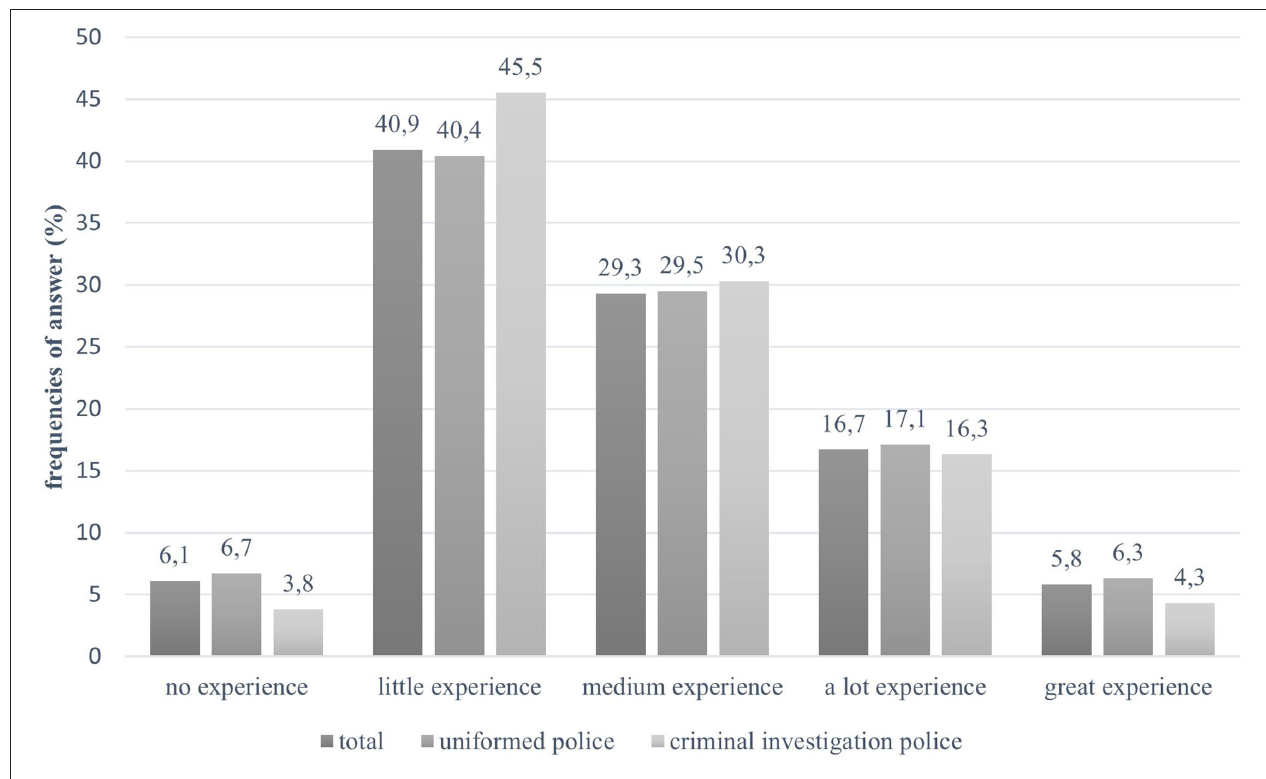
FIGURE 1 | Police officers’ personal experiences with mental